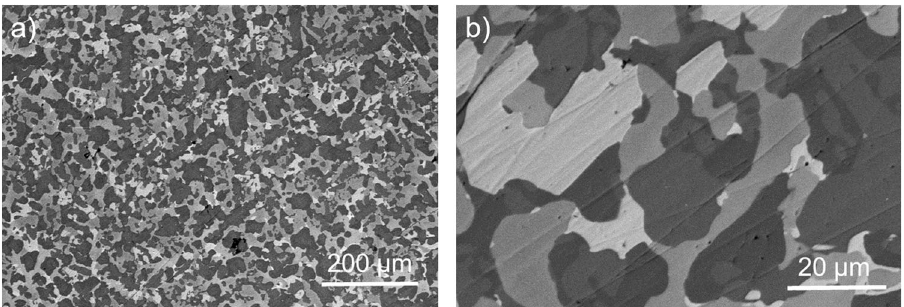
Fig. 4 SEM micrographs after the PD scan in acidic brine solution. Showing results of RAW-2 a low and b high magni fi cation. The scale bar on the left image is 200 µm and the right image is 20 µm.